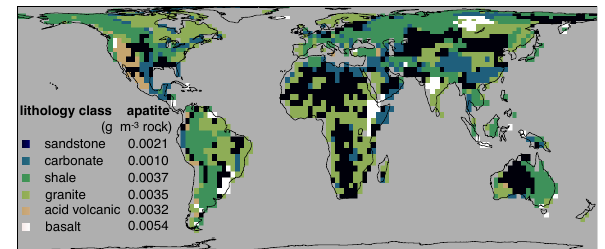
Figure 5. Map of the lithological classes and their respective ap- atite concentrations (g apatite m − 3 ). Lithological classes taken from Amiotte Suchet and Probst (1995), values for the concentration of apatite were calculated from Newman